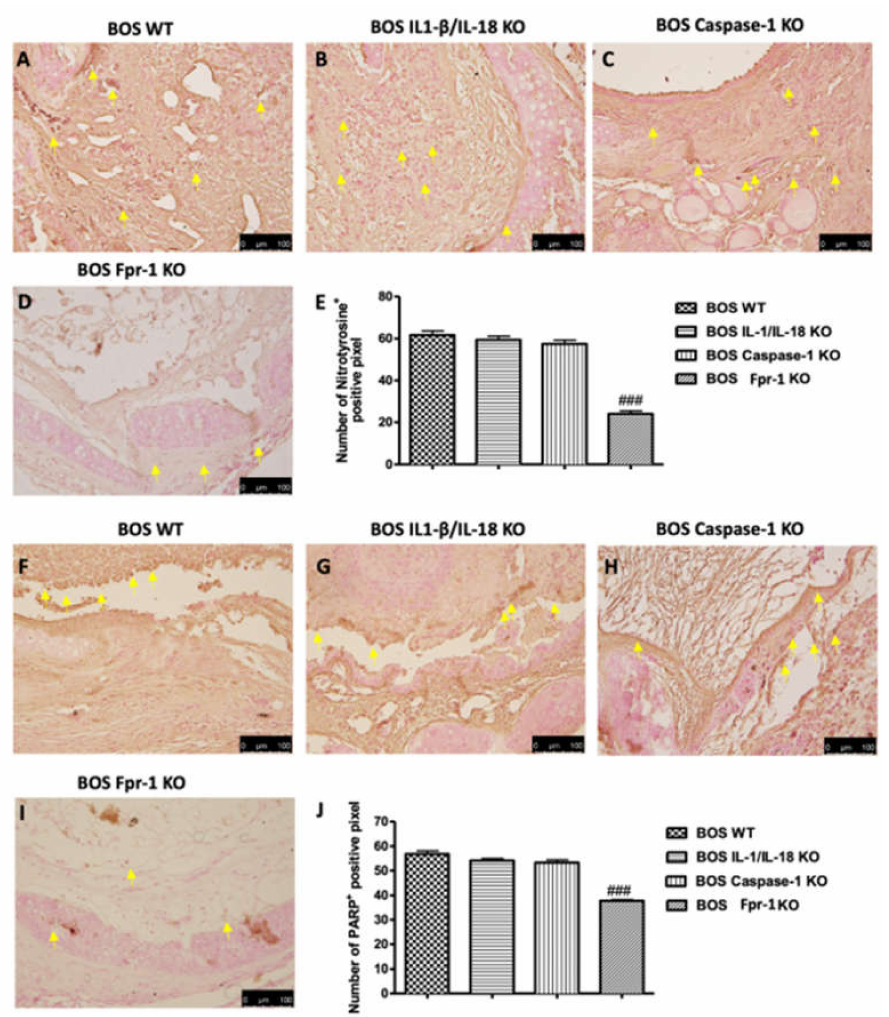
Figure 4. E ff ects of the absence of IL-1 β / IL-18, Casp-1, and Fpr-1 on Nitrotyrosine formation and PARP activation. Immunohistochemistry evaluation of nitrotyrosine expression: WT ( A ), IL-1 β / IL-18 KO ( B ), Casp-1 KO ( C ), Fpr-1 KO ( D ), densitometric analysis ( E ). Immunohistochemistry evaluation of PARP expression: WT ( F ), IL-1 β / IL-18 KO ( G ), Casp-1 KO ( H ), Fpr-1 KO ( I ), densitometric analysis ( J ). Yellow arrows point the positive cells. For immunohistochemistry, n = 5 animals from each group were employed. A p -value less than 0.05 was considered significant. ### p < 0.001 versus the WT